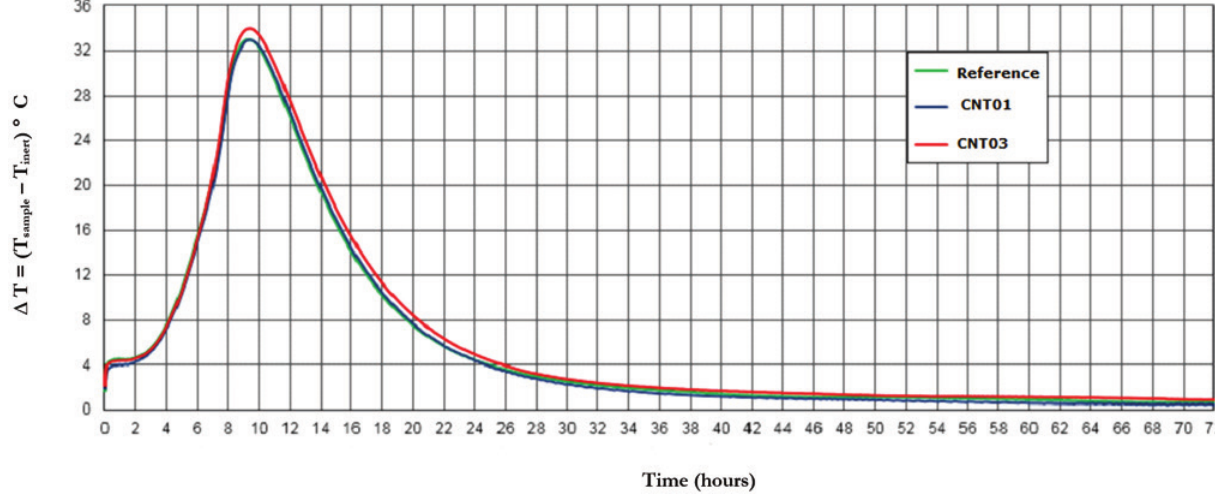
Representative thermal profiles of the cement